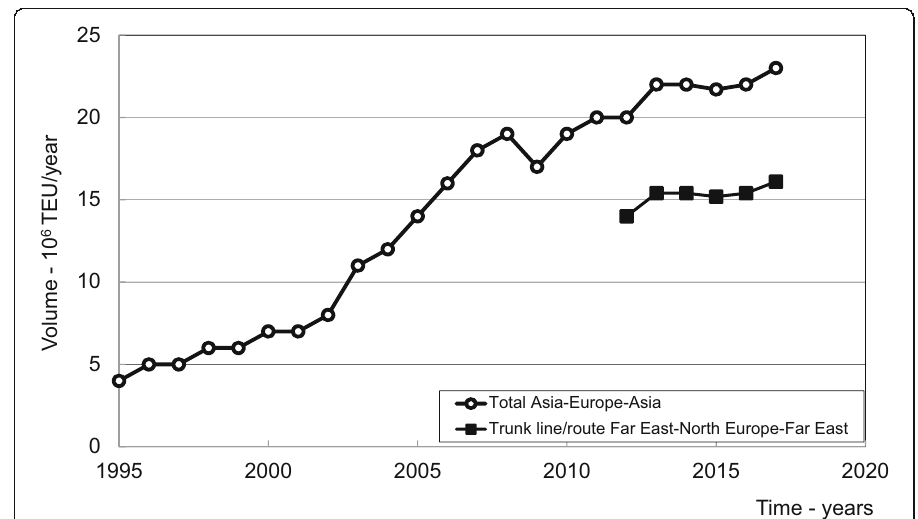
Fig. 6 Development of the sea shipping container flows in the Asia-Europe-Asia sea shipping market over time (UNCTAD 2017)